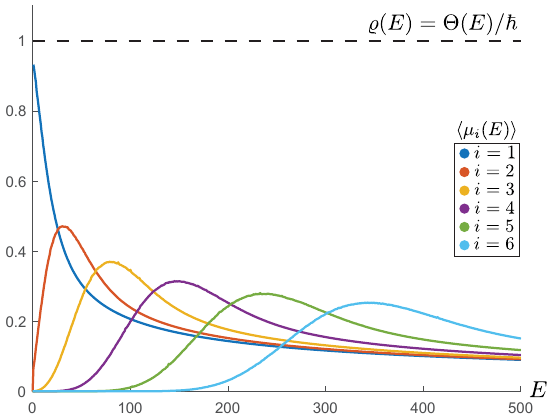
Figure 2. Expectation value of µ i ( E ) , defined in (3.14), for the first few values of i , computed from the sample of random matrices used to generate the plots in figure 1. Taking the sum of these curves one recovers the spectral density % ( E ) = Θ( E ) / ~ with ~ = 1